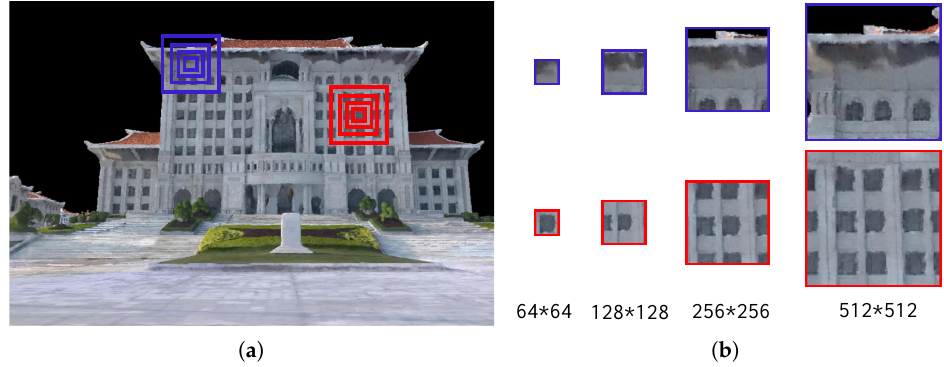
Figure 7. Various size of rendered image patches in two typical locations. ( a ) Different bounding boxes of two locations in a rendered image. ( b ) Various size image patches of the bounding boxes in ( a ).